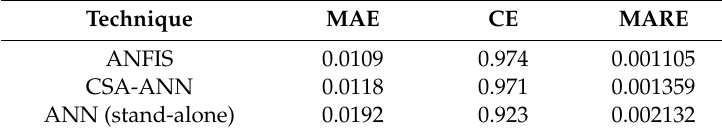
Table 3. Performance evaluation for validation data